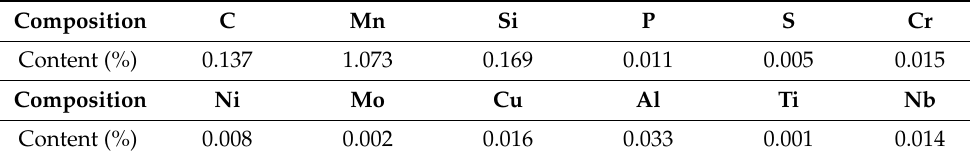
Table 1. Chemical compositions (%) of A516 carbon steel.